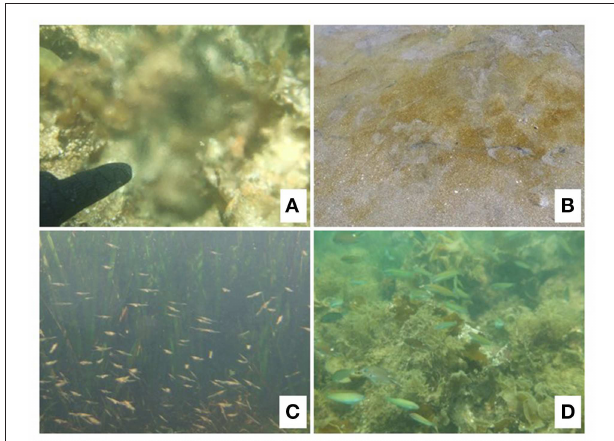
FIGURE 1 | Underwater view of spring-type submarine groundwater discharge (SGD) at a volcanic coast in Beppu Bay, southwestern Japan (A) , benthic microalgae flourishing around SGD at a sandy beach in Yamagata Prefecture (B) , misids gathering around SGD at a seagrass bed in Hokkaido Prefecture (C) , and aggregation of labrid and pomacentrid fishes around SGD in Beppu Bay, Japan (D) . All image credits: